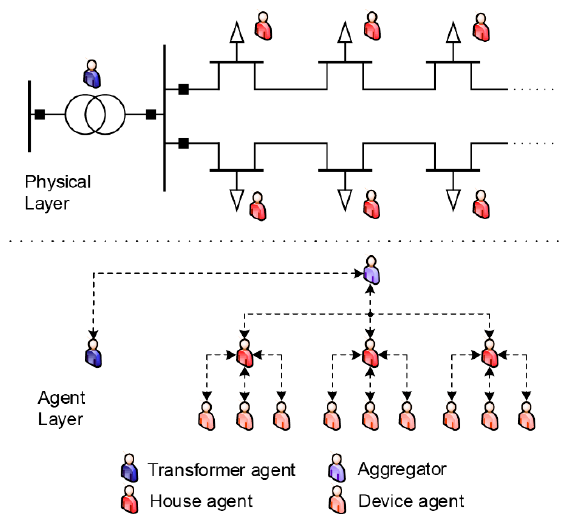
Figure 1. Multi-Agent Systems (MAS)-based system architecture.